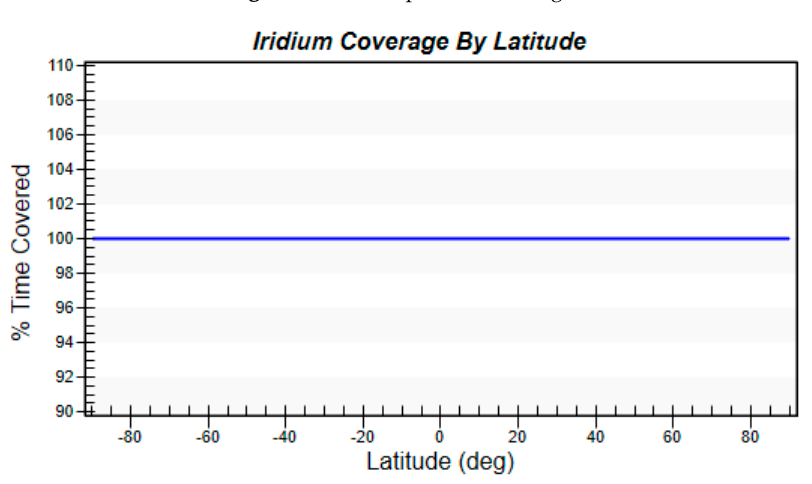
Figure 6. Iridium percent coverage.